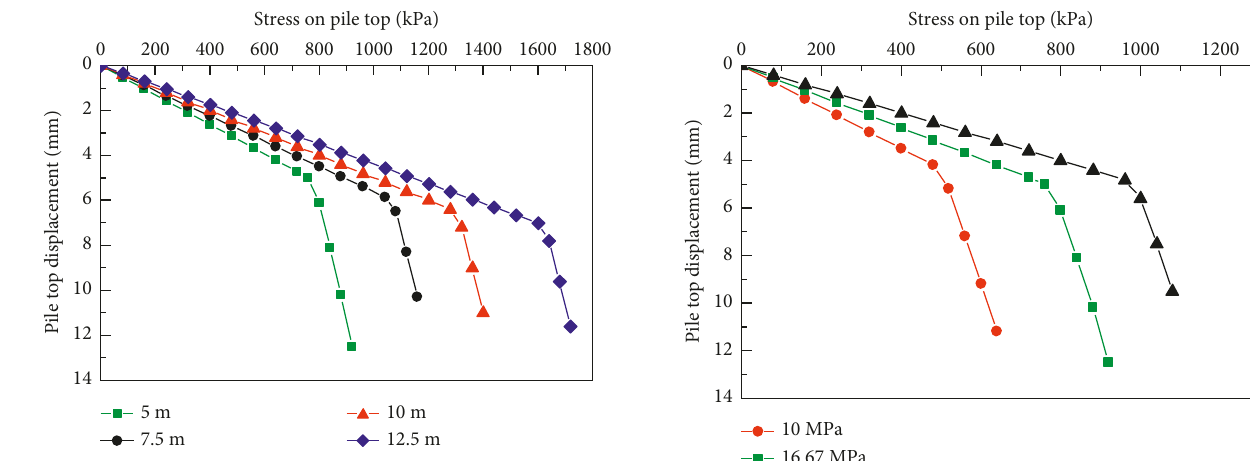
Figure 15: Load-settlement curves of piles with different pile lengths.